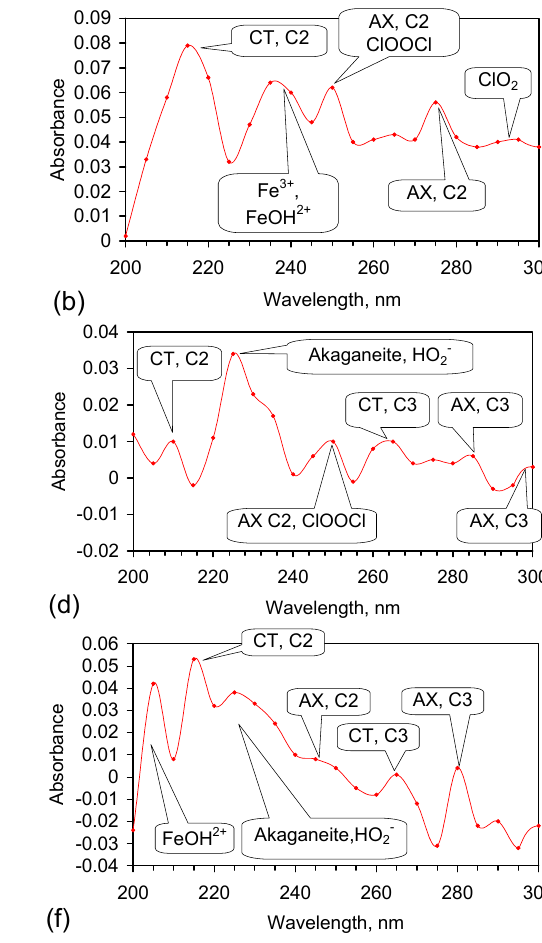
Figure C36. ZVM TPA example Trial E146]. 16th Reuse; Operating Temperature: 13–20 °C; Oxidising Environment: Water volume in the reactor = 0.24 m 3 ; ZVM TPA from Trial E145 in a cartridge = 0.4 kg; Air flow = 120 L·h − 1 . Acid Oxidising Environment: Water volume in the reactor = 5.4 L; ZVM TPA from Trial E144 in a cartridge = 0.4 L; Gas flow (80% N 2 + 20% CO 2 ) = 3.3 L·h − 1 . ( a ) Eh vs. time; ( b ) pH vs. time; ( c ) pH vs. Eh; ( d ) Salinity vs. time; ( e ) Salinity calculated from normalised data vs. salinity calculated from raw data; ( f ) EC vs. time.